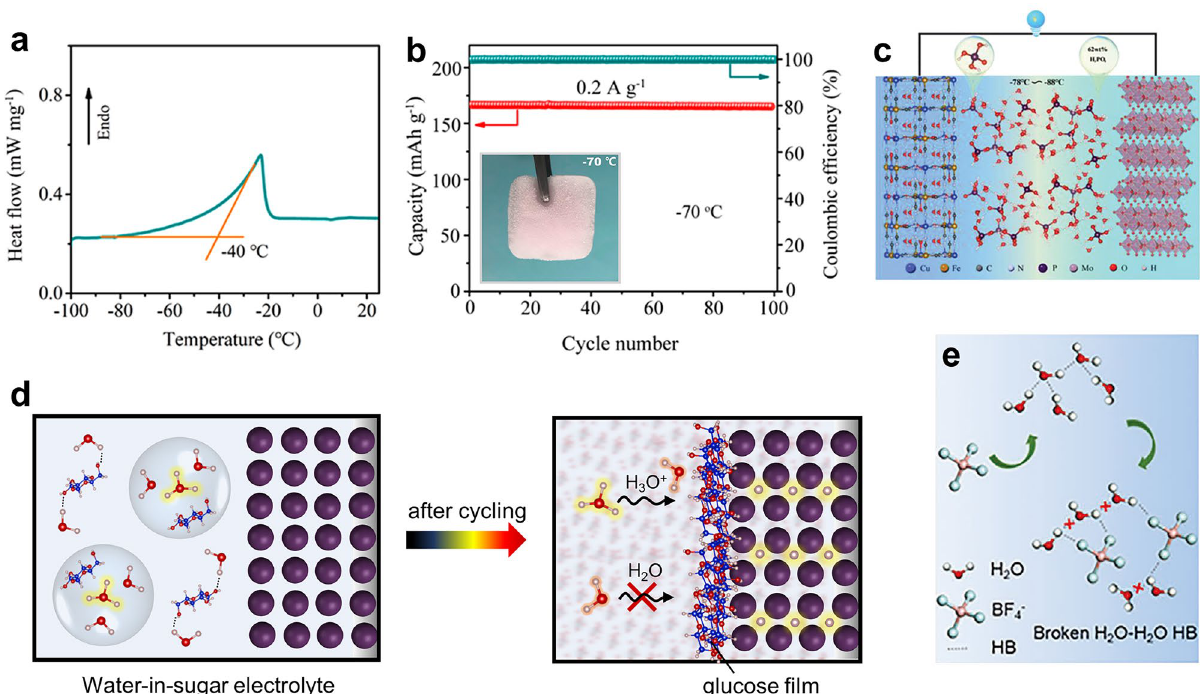
Fig. 6 a Differential scanning calorimetry measurement for the 2 M H 2 SO 4 + 2 M MnSO 4 electrolyte. b Cycle performance of the MnO 2 @ graphite felt//MoO 3 cell at -70 °C. Inset: the photograph of the frozen acid electrolyte at −70 °C [17]. Copyright 2020, American Chemical Soci- ety. c Schematic of the aqueous proton battery device in H 3 PO 4 electrolyte [22]. Copyright 2020, Wiley–VCH. d Schematic illustration of water- in-sugar electrolyte for α -MoO 3 proton-battery anodes [43]. Copyright 2021, Wiley–VCH. e Schematic illustration on a possible mechanism of H-bond networks destruction of original water molecules by introduce BF 4− anion [75]. Copyright 2021,